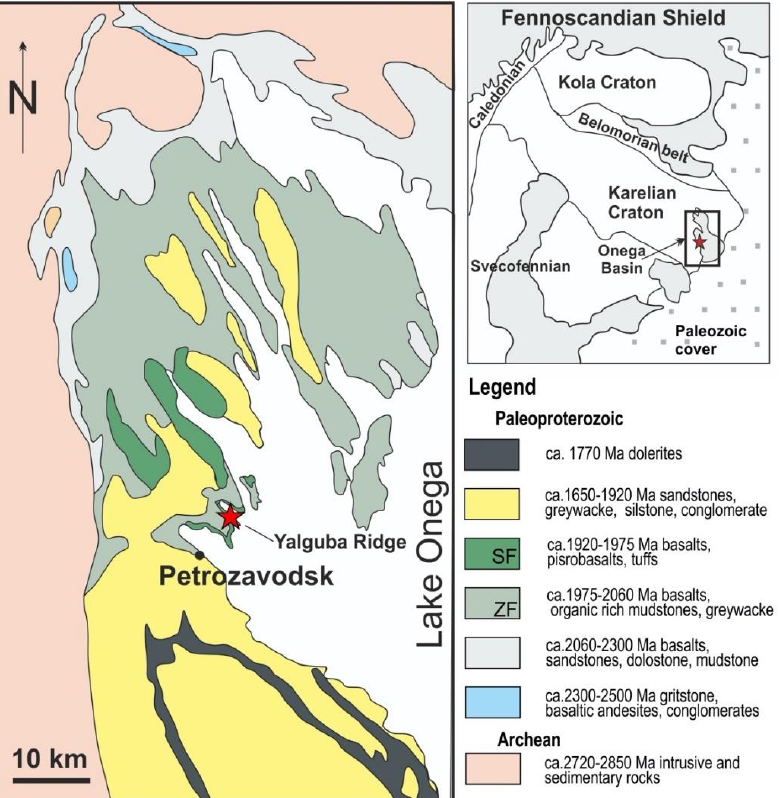
Figure 1. Schematic geological map of the western part of the Onega Basin and sampling locations. Modified from [33]. SF — Suisaari Formation; ZF — Zaonega Fm; asterisk marks the sampling area. Reproduced with permission from Kulikov V.S., Contributions to Mineralogy and Petrology; published by Springer-Verlag, 1998.